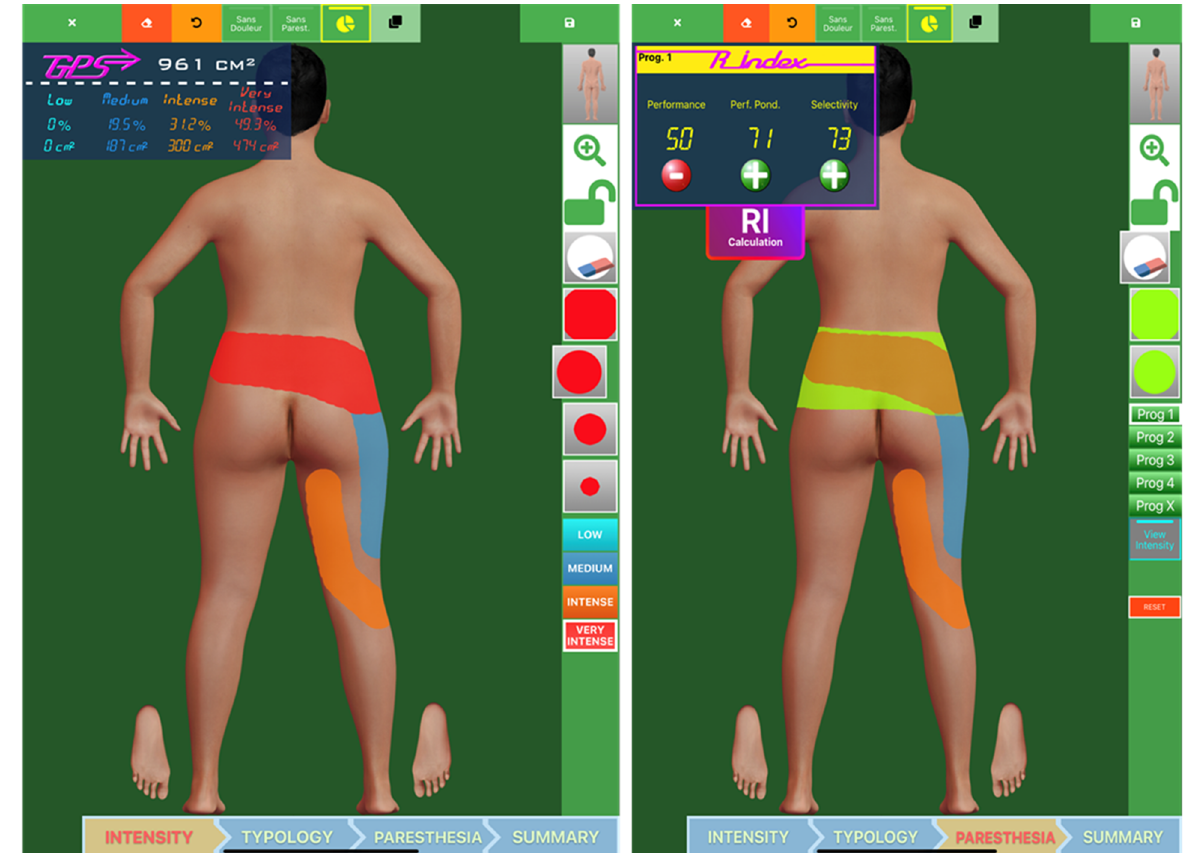
Figure 1. Pain mapping software used to assess pain surface and pain coverage where the patient could draw different painful zones. The pixels in the patient drawing are then converted into cm², using several anatomical landmarks, patient morphology and morphometry. Four colors are available for patients to represent the different pain intensities. Pain coverage can then be obtained by drawing paresthesia (in green), which is converted to a percentage of pain coverage (performance).